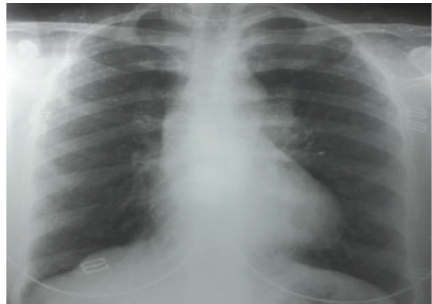
Figure 1: Posteroanterior chest X-ray showing a mild increase in cardiothoracic ratio.